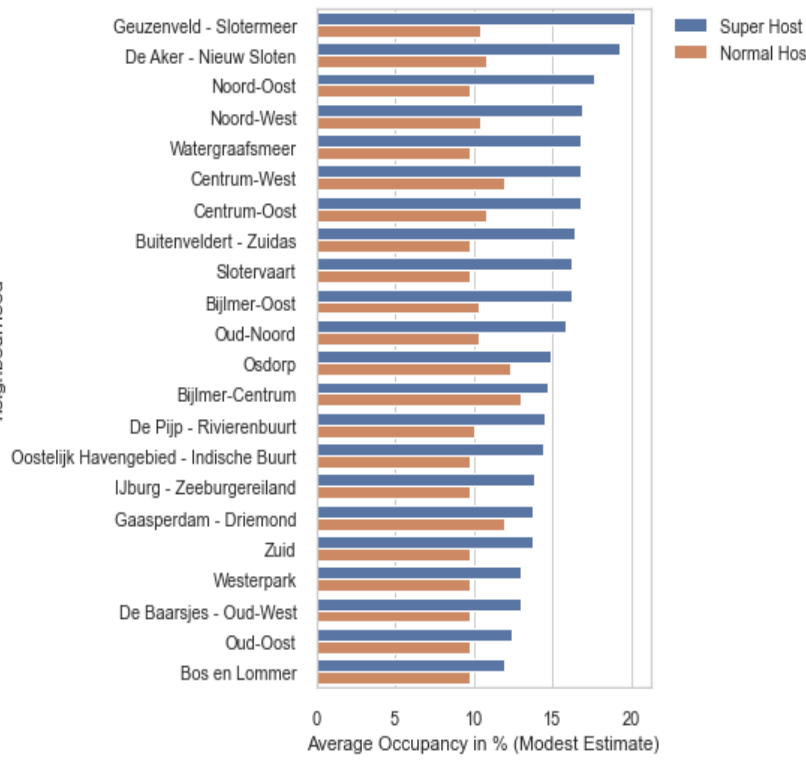
Figure 6. Occupancy by area and host